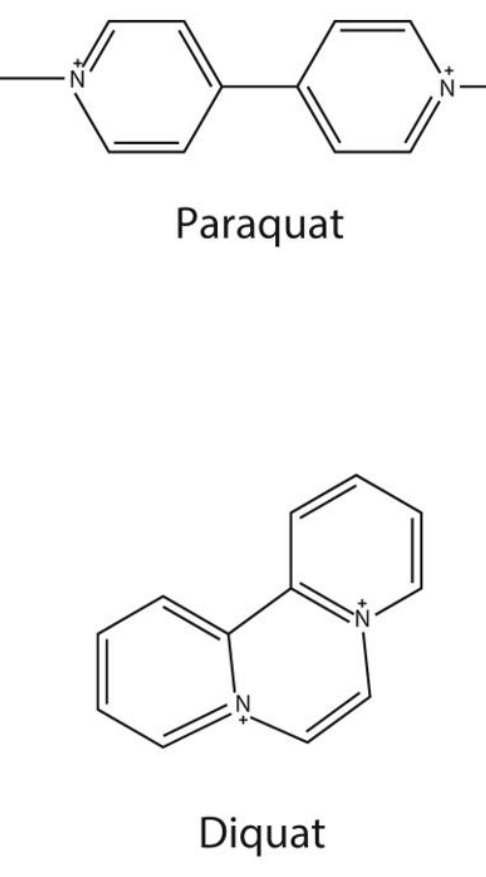
Figure 1. Chemical structure of paraquat and diquat.